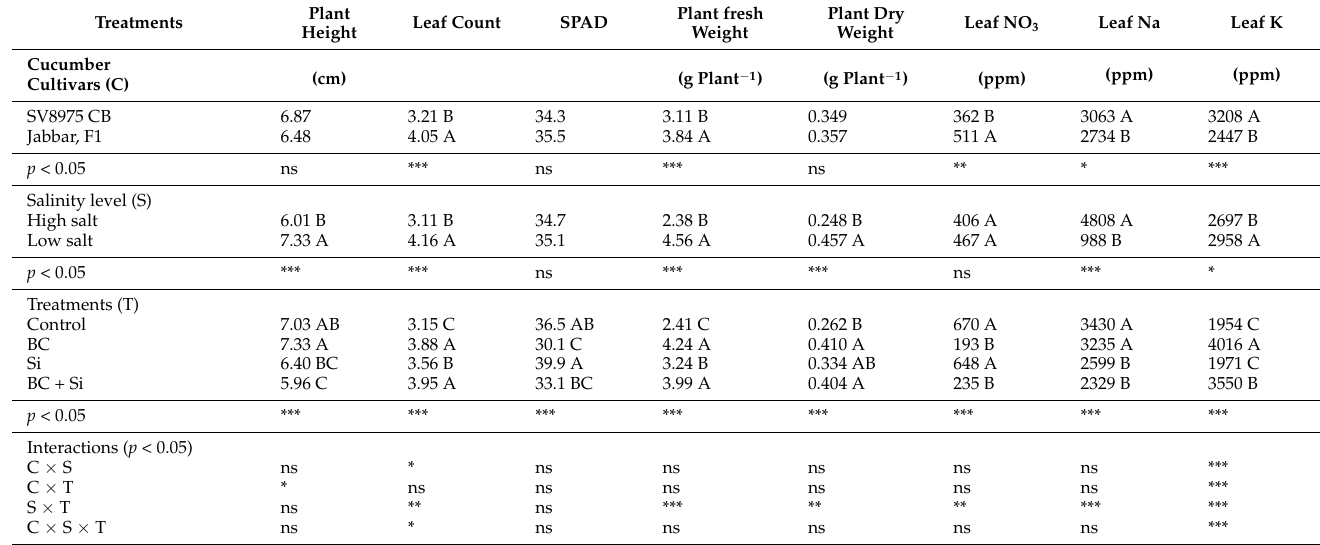
Table 4. Plant height, leaf count, SPAD, biomass, and sap nutrient content and significance levels for Experiment